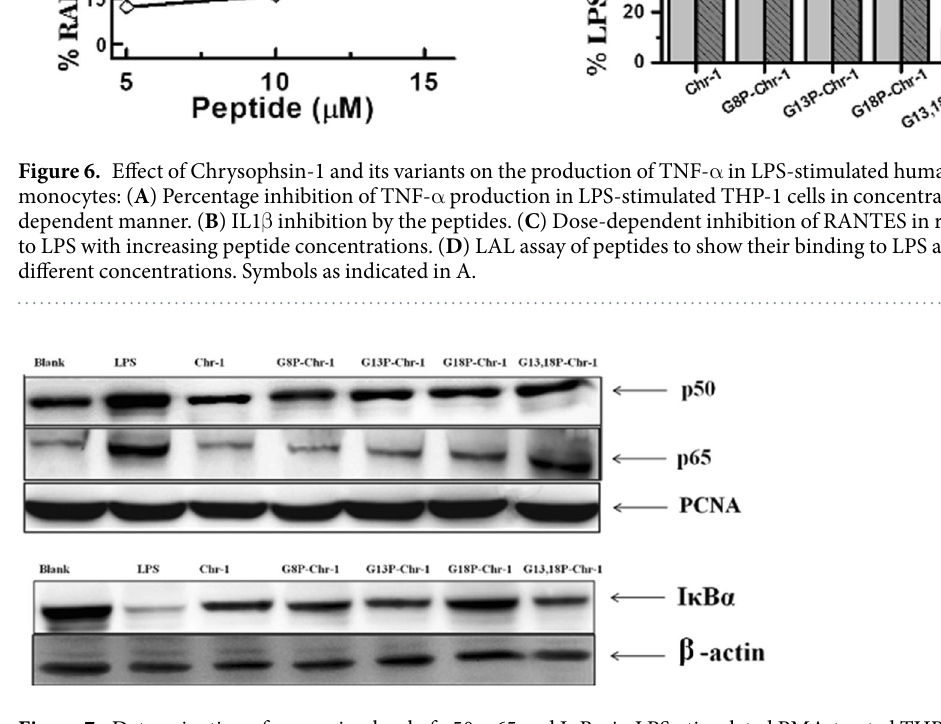
Figure 7. Determination of expression level of p50, p65 and I κ B α in LPS-stimulated PMA-treated THP-1 cells in the presence of Chrysophsin-1 and its analogs. PCNA was used as internal nuclear loading control. β -actin used as internal control for I κ B α . ctrl stand for untreated cells. Peptide concentration was 10 μ M and LPS 100 ngml − 1